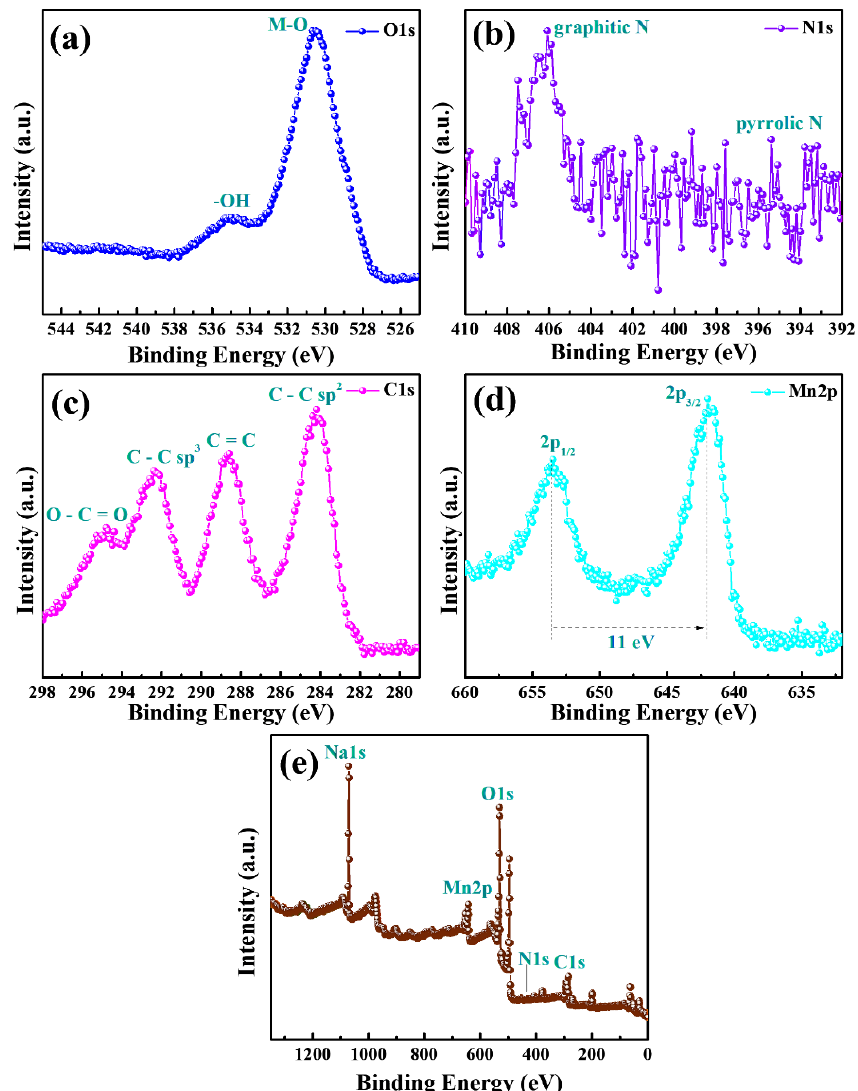
Figure 6. XPS analysis of MnO 2 @CE/PPy. ( a ) O 1 s, ( b ) N 1 s, ( c ) C 1 s, and ( d ) Mn 2 p binding energy and ( e ) survey spectrum.